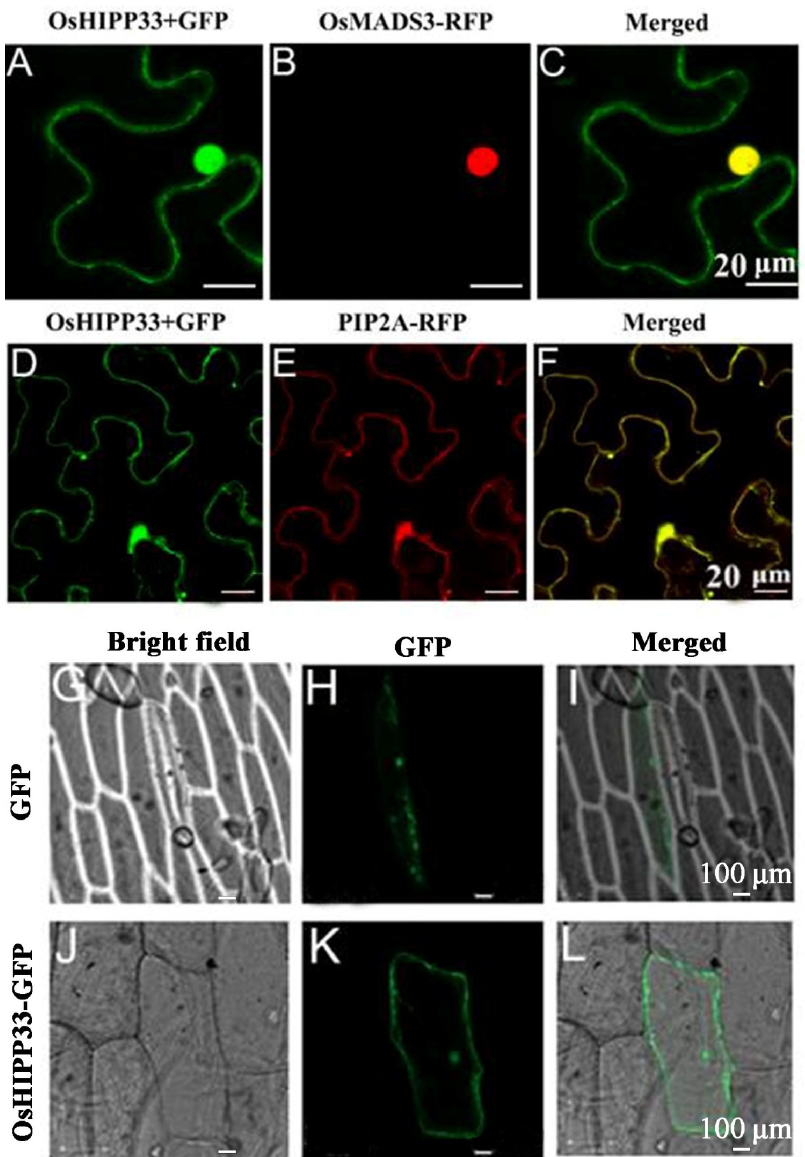
Figure 2. Subcellular localization of OsHIPP33 . ( A – F ) Tobacco subcellular localization. ( A , D ) Green fluorescence of OsHIPP33 ‐ GFP fusion protein. ( B ) The red fluorescence of nuclear maker ( OsMADS3 ). ( C ) The green fluorescence of the OsHIPP33 ‐ GFP fusion protein coincides with the red fluorescence of the nuclear maker ( OsMADS3 ). ( E ) The red fluorescence of cell membrane maker (PIP2A). ( F ) The green fluorescence of OsHIPP33 ‐ GFP fusion protein coincides with the red fluorescence of cell membrane maker (PIP2A). ( G – L ) Detection of onion subcellular localization. ( G , J ) Bright field. ( H ) The fluorescence of GFP. ( I ) Merged between bright field and GFP fluorescence. ( K ) Fluorescence of OsHIPP33 ‐ GFP fusion protein. ( L ) The merger of OsHIPP33 ‐ GFP fusion protein fluorescence and bright field.